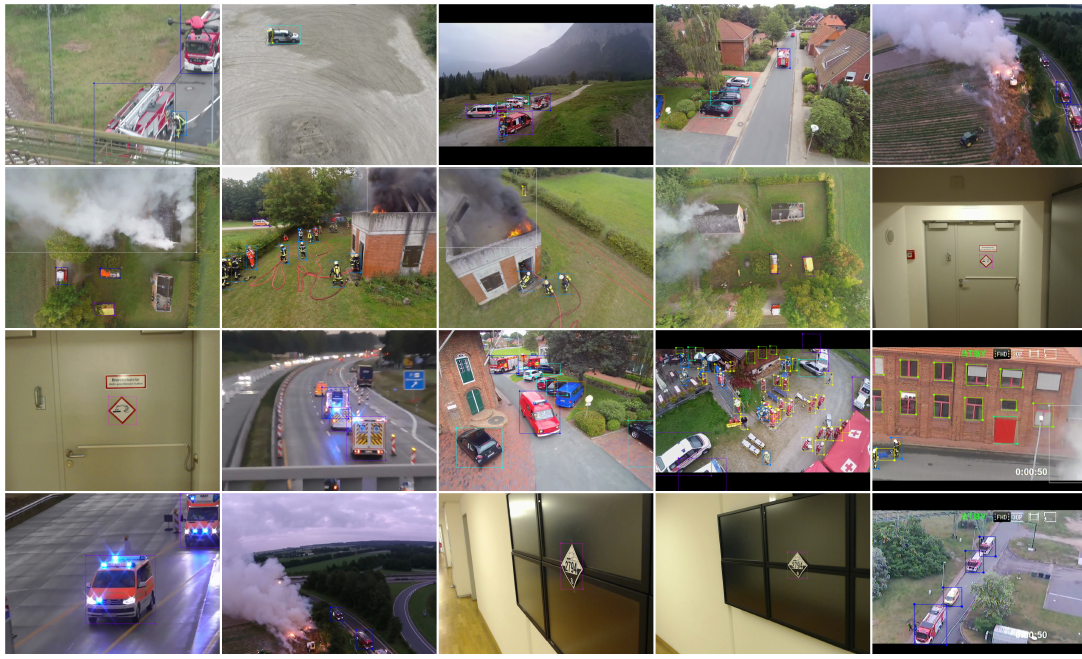
Figure 5. Example images and labels of EffFeu project-specific